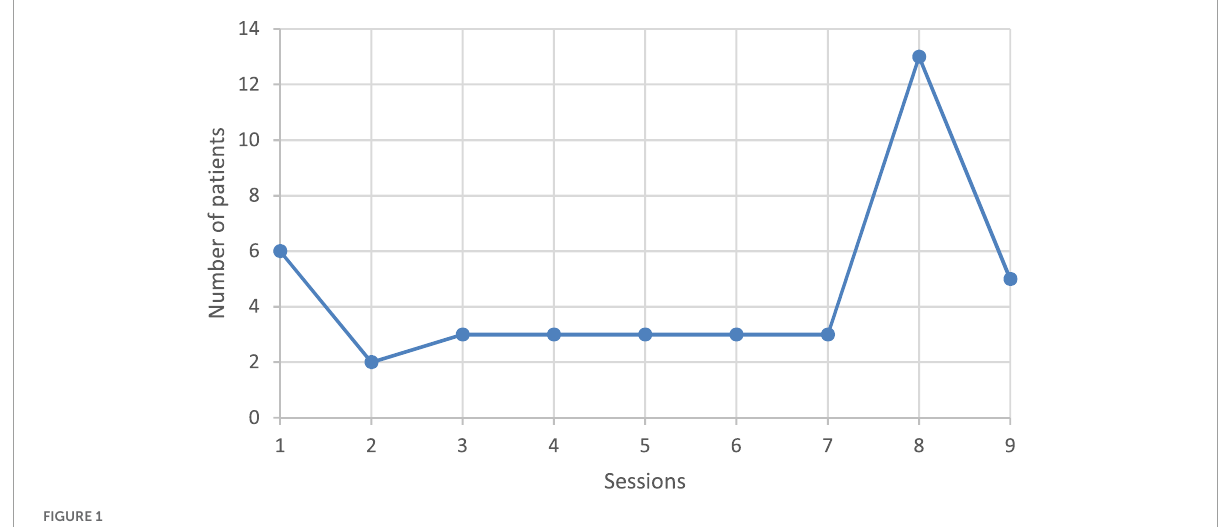
FIGURE1 Attendance (number of sessions attended for each